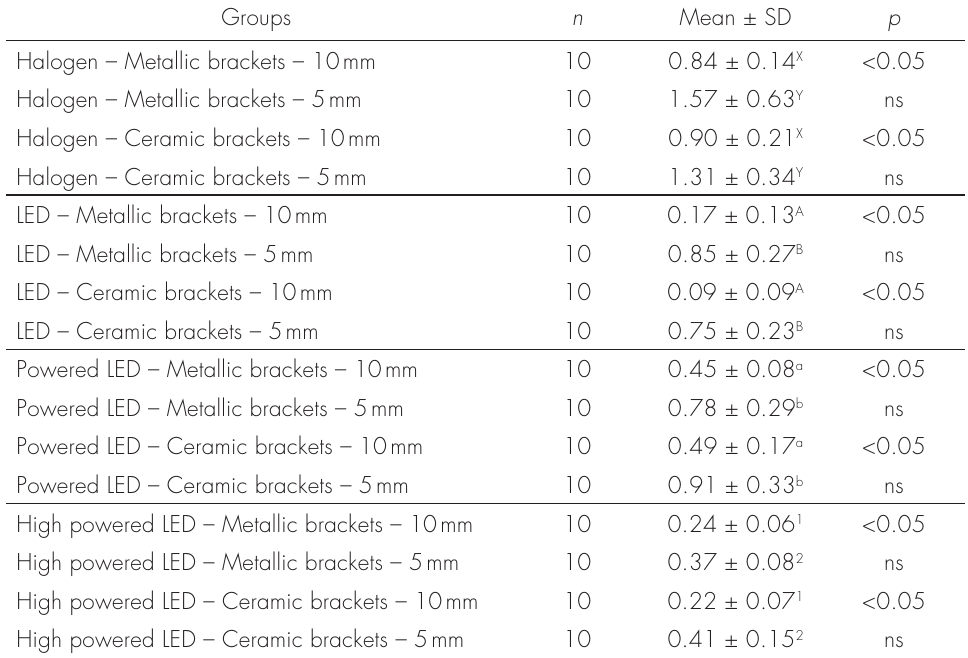
Table V. Pulp chamber temperature changes in subgroups and statistical comparisons. Groups